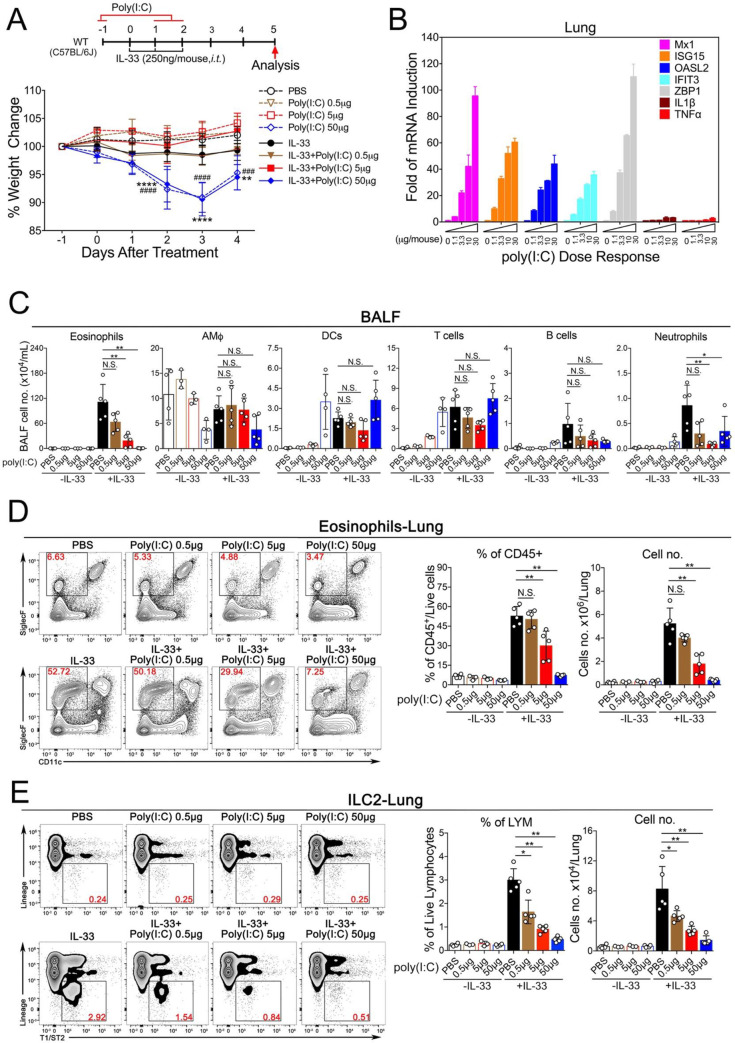
Poly(I:C) activates innate immune responses in a dose-dependent manner and inhibits IL-33 induced eosinophilia and ILC2 proliferation.A. Experimental setup of an acute lung inflammation model that illustrates the animal groups, the corresponding treatment regimen and timeline (upper panel) and weigh changes following treatment as indicated. Error bars represent SEMs. Statistics of the weight changes was determined using the Two-Way ANOVA. The dot lines (animal groups treated with either PBS or increased amount of Poly(I:C) without IL-33, ### p < 0.001, #### p < 0.0001); the sold lines (animal groups treated with PBS or increased amount of Poly(I:C) with IL-33, ** p < 0.01, ****p < 0.0001). B. Transcriptional induction of gene expressions by Poly(I:C) in mouse lungs. C. Groups of mice as indicated were treated with PBS, IL-33 in presence of increased doses of Poly(I:C) as indicated. Bronchoalveolar lavage fluid (BALF) was collected and analyzed for differential immune cell types. The result is a pool of two independent experiments. (n = 3–5 per group as indicated with open circles). D. Administration of Poly(I:C) in a dose-dependent manner reduced the percentage and number of lung-eosinophils after exposure to IL-33. (n = 3–5 per group as indicated with open circles). E. Poly(I:C) treatment decreased the number of lung-ILC2 cells after exposure to IL-33 in a dose-dependent manner. (n = 3–5 per group as indicated with open circles). Unless otherwise indicated, P value was determined using Mann-Whitney test, P value ≥0.05 was not considered statistically significant [N.S.]). * p < 0.05, ** p < 0.01.